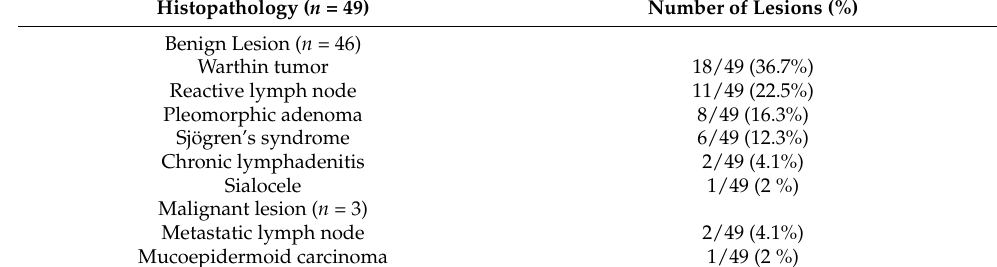
Table 1. Final diagnosis of 47 incidental parotid lesions based on histopathologic results.